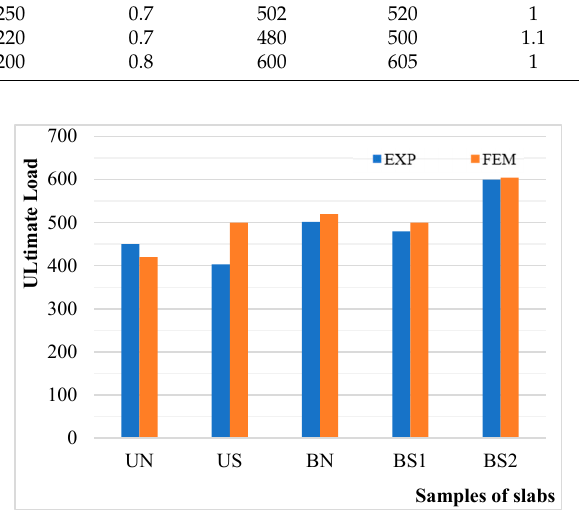
Table 4. Experimental and FEM of cracking load, ultimate load, and ultimate deflection.